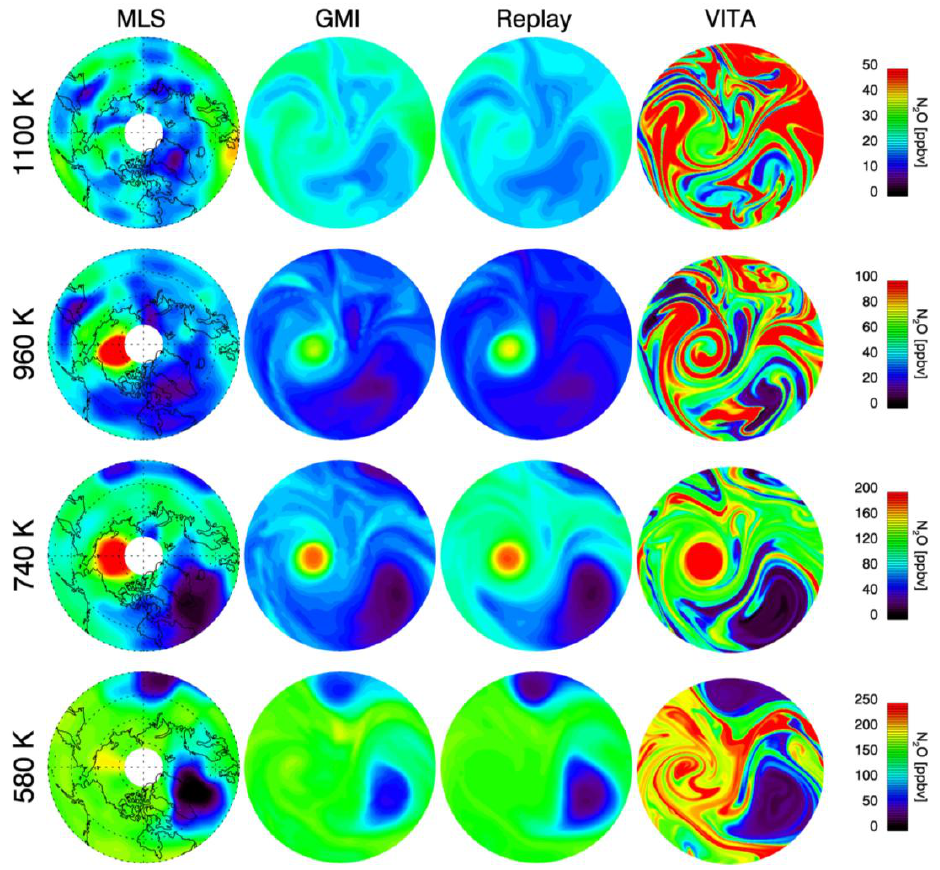
Fig. 7. MLS N 2 O (first column) from 50–90 ◦ N at several potential temperature levels (rows correspond to 1100, 960, 740, and 580K) for 4 April 2005 along with simulations from GMI (second column), Replay (third column), and VITA (fourth column). Red (blue) indicates high (low) N 2 O values.